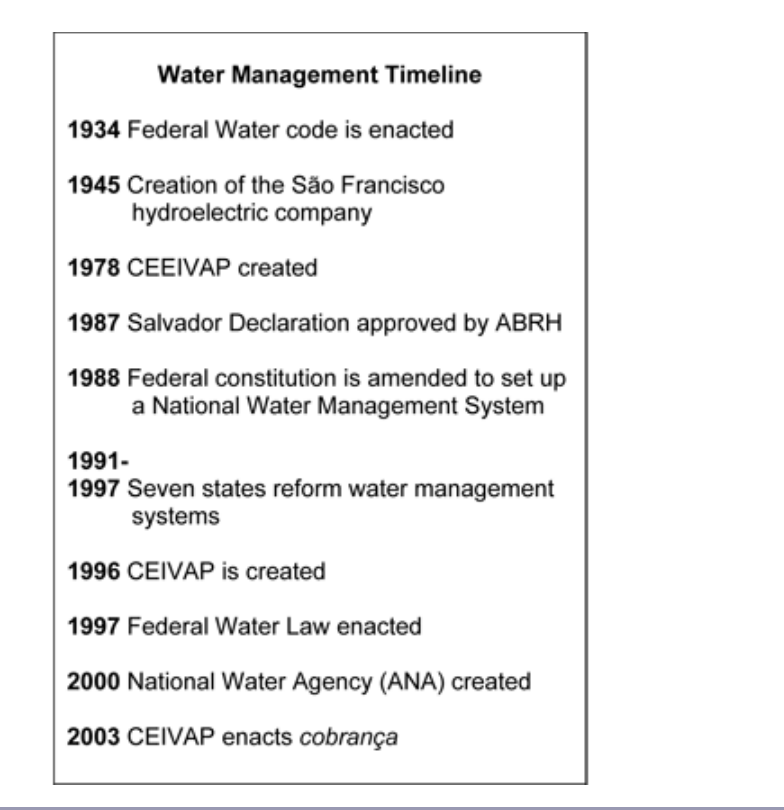
Fig. 2. Water management timeline. Shows the primary federal-, state-, and basin-level events relevant to the CEIVAP